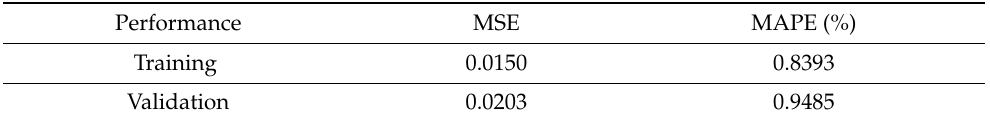
Table 3. Model performance.